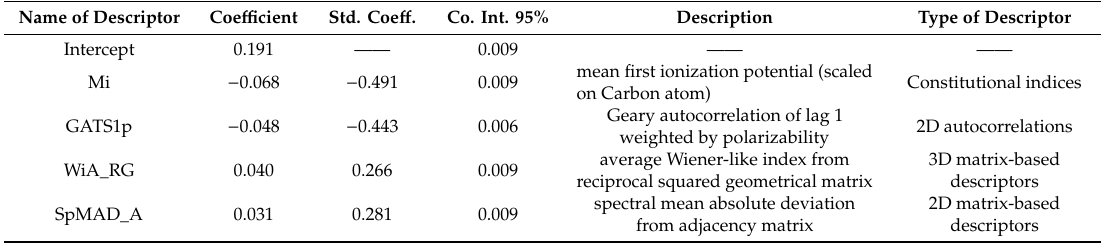
Table 2. Description and statistical coe ffi cients of the descriptors in the 4-variable